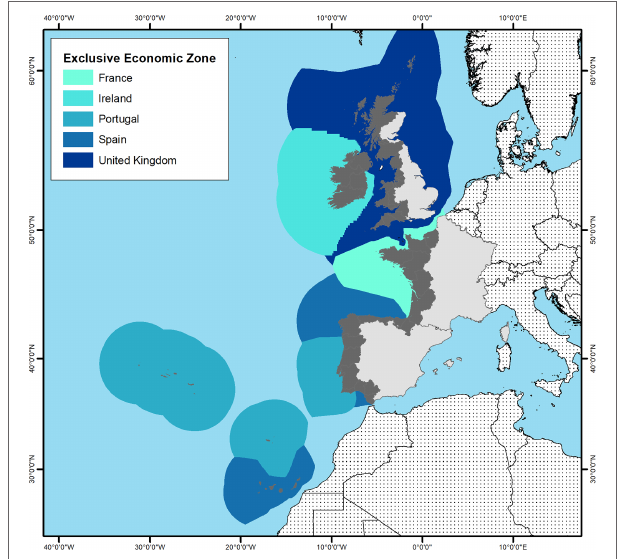
FIGURE 1 | The North East Atlantic Area with EEZ countries involved in this